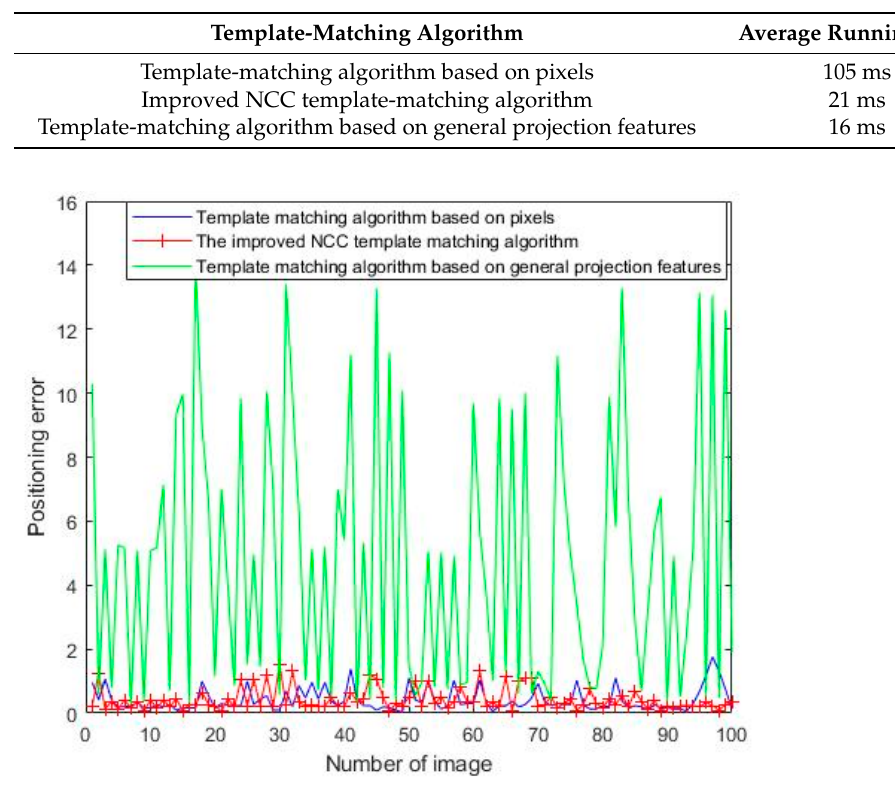
Table 1. Operating time comparison of three template-matching algorithms.